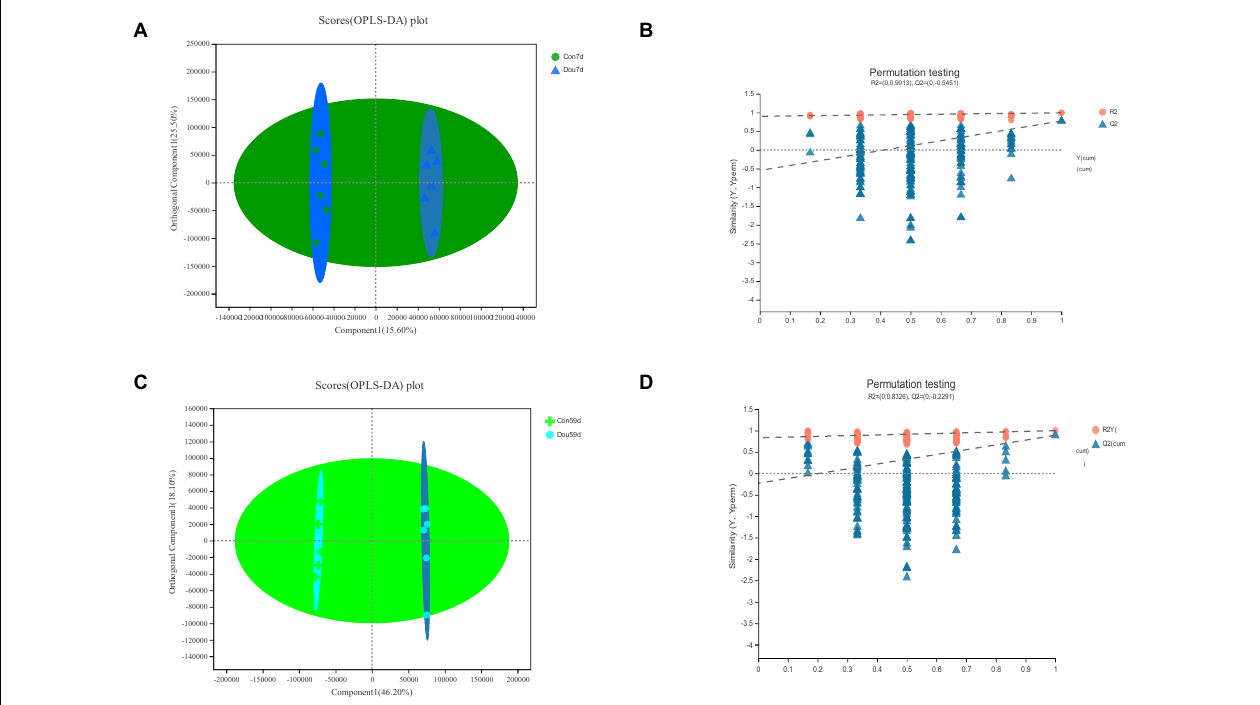
FIGURE 2 | In Dou vs. Con, panels (A,B) for 7th day and panels (C,D) for 59th day. Panels (A,C) are OPLS-DA scores plot. Panels (B,D) are OPLA-DA permutation tests. (B) R 2 X (cum) = 0.571, R 2 Y (cum) = 0.994, Q 2 = 0.777. (D) R 2 X (cum) = 0.705, R 2 Y (cum) = 0.999, Q 2 = 0.89.